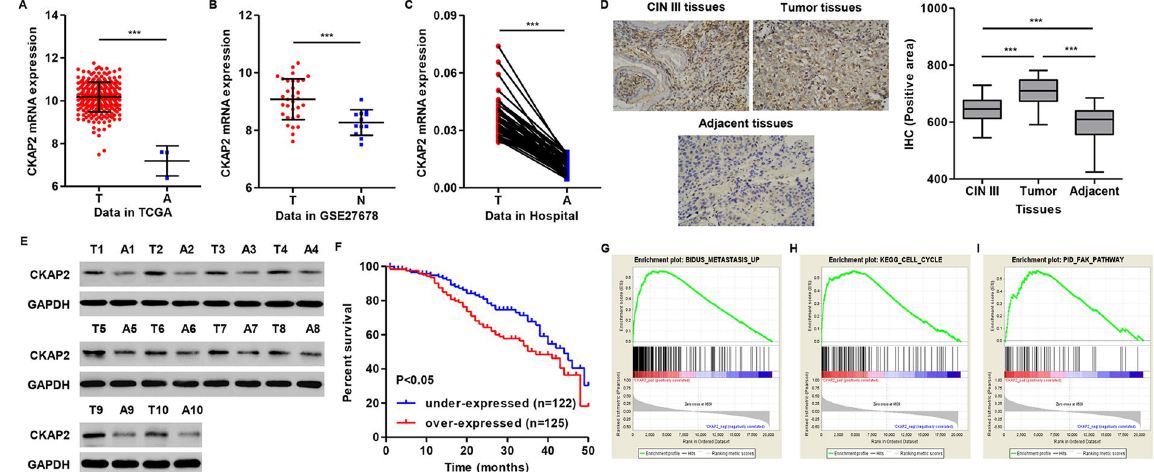
Figure 1. Expression of CKAP2 in cervical carcinoma tissues and cell lines. ( A , B ) Bioinformatics was also used to analyze the expression level of CKAP2 in TCGA data and GSE27678. ( C ) Comparison of expression level of CKAP2 between cervical carcinoma and adjacent tissues in Hospital by Real-time PCR. ( D ) Representative immunohistochemical staining for CKAP2 in cervical carcinoma, HPV-16-positive CIN III and adjacent tissues. ( E ) Expression of CKAP2 in ten primary cervical carcinoma tissues and their corresponding adjacent tissues measured by Western blot. ( F ) The survival time of cervical carcinoma specimens showed lower CKAP2 expression level patients were notably longer than that of higher CKAP2 patients. Genes in the metastasis up ( G ), cell cycle ( H ) and FAK pathway ( I ) showed significant enrichment in CKAP2-higher expression tissues versus CKAP2-lower expression tissues. T, tumor tissues; A, adjacent tissues; N, normal tissues; *** P < 0.001.